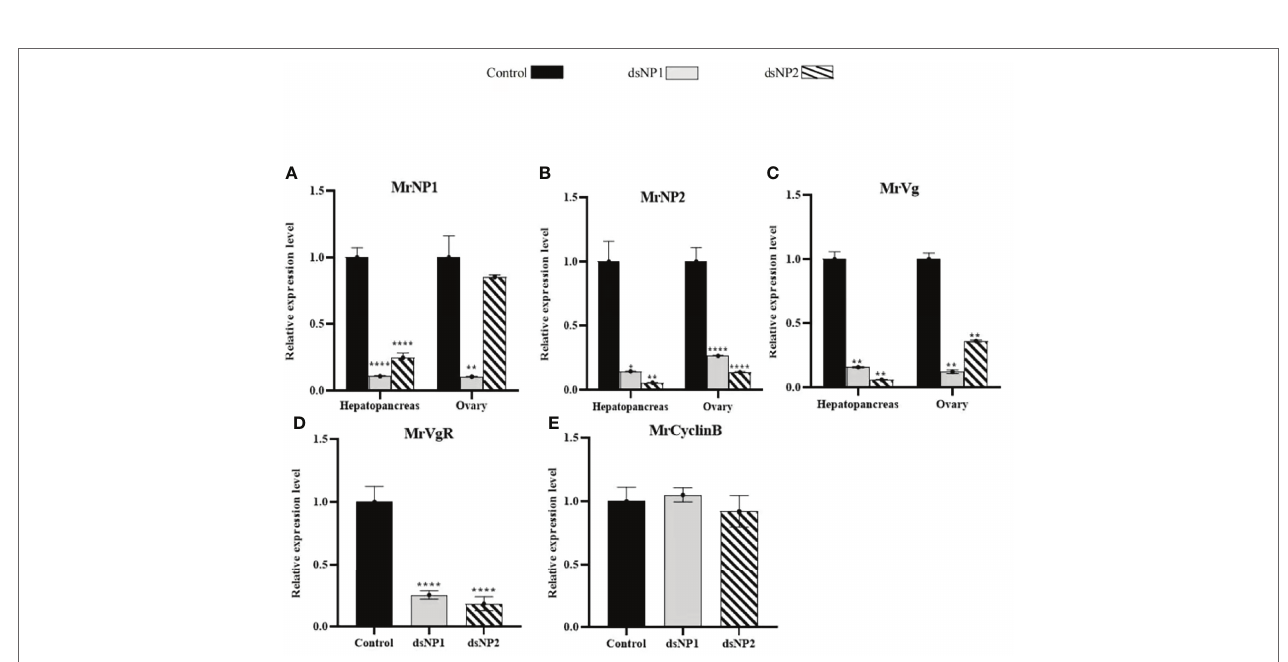
FIGURE 6 | In vivo RNA interference of dsMrNP1 and dsMrNP2. Expression of (A) MrNP1, (B) MrNP2, and (C) MrVg after shrimps were injected with dsTFV (black bar), dsMrNP1 (gray bar) and dsMrNP2 (diagonally stripe bar). Expression of VgR (D) and CyclinB (E) in the ovary (data shown are means of relative expression levels ± SD. One-way ANOVA method was used in the statistical analysis . The significance levels are: * , (P < 0.05); **,(P < 0.01); ***, (P < 0.005) ; and ****,(P<0.001).